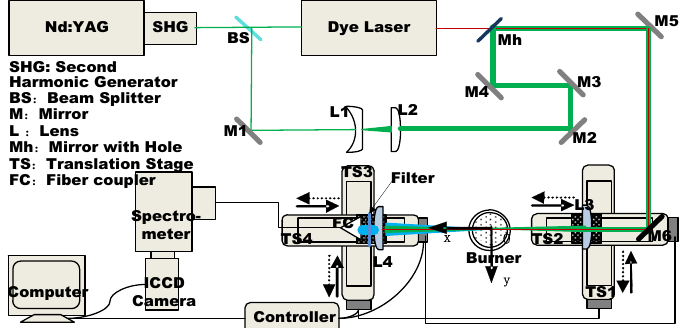
Figure 3. Two-dimensional Scanning CARS experimental facility. Figure 2. Diagram of two-color PLIF temperature measurement. PLIF fluorescence signals from the P 1 (7) and Q 2 (11) transition lines are recorded and the typical image is shown in the left image of Figure 4. The CARS system is vertical scanning to take the temperature at those black rectangular points. The temperature results from CARS are shown in the right graph in Figure 4, with a standard deviation (SD) of 28–58 K. Standard error (SE) of the CARS results is 6–13 K when averaged 20